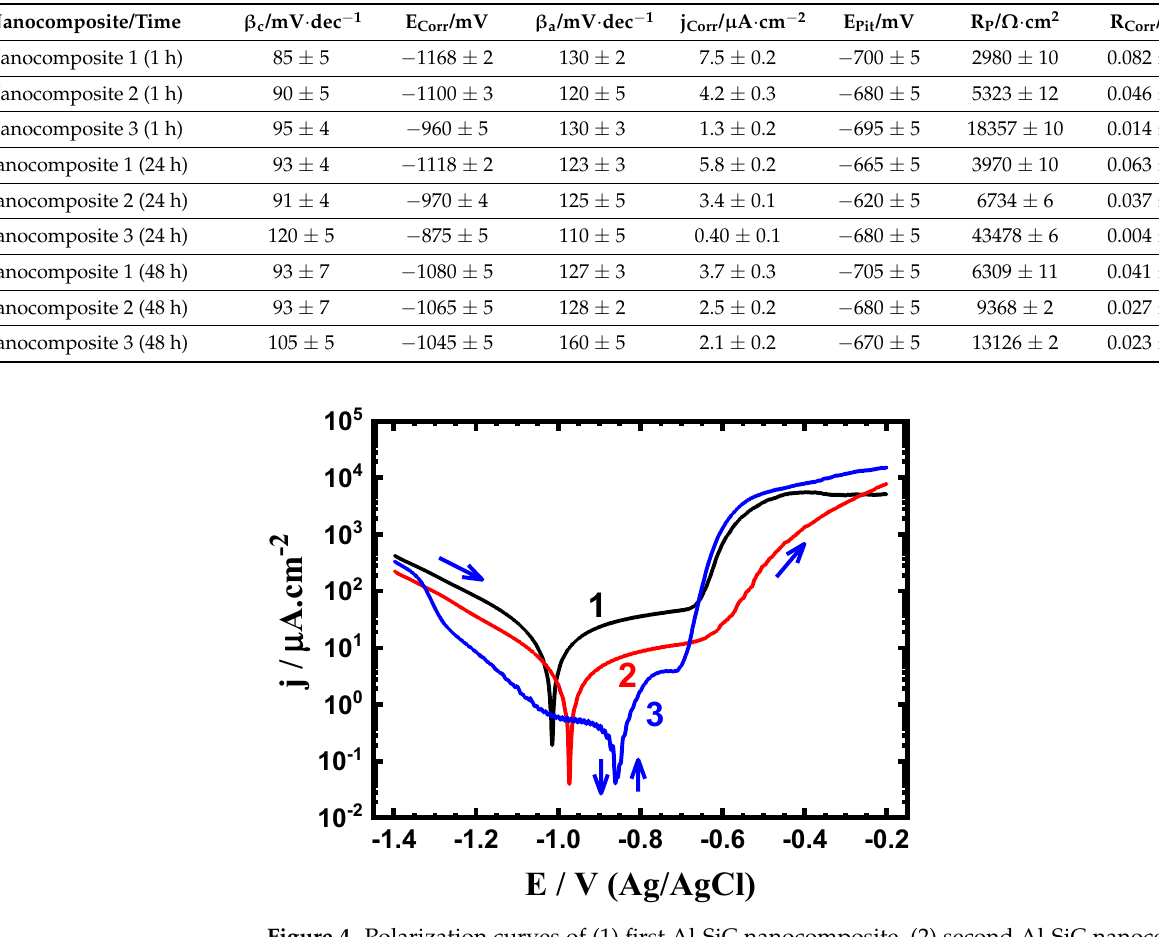
Figure 4. Polarization curves of (1) first Al-SiC nanocomposite, (2) second Al-SiC nanocomposite and (3) third Al-SiC nanocomposite after 24h exposure in 3.5%NaCl.